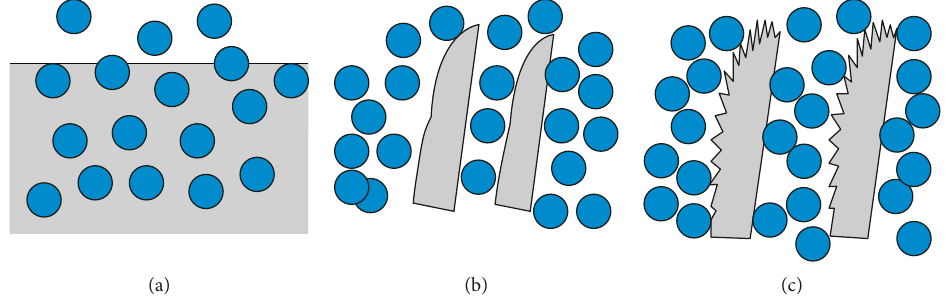
Figure 4: Lamellar pore-forming process in the aqueous